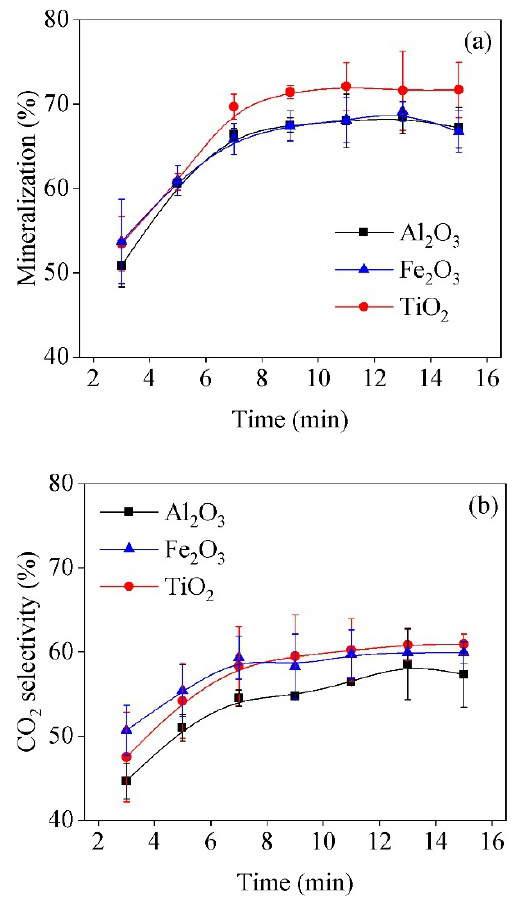
Figure 7. Effect of time on ( a ) the mineralization and ( b ) the CO 2 selectivity in a DBD reactor filled with Al 2 O 3 , Fe 2 O 3 , and TiO 2 . (Discharge power: 55 W; driving frequency: 12.6 kHz; initial naphthalene concentration: 21.5 ppm; total gas flow rate: 500 mL/min; discharge gap: 3 mm).